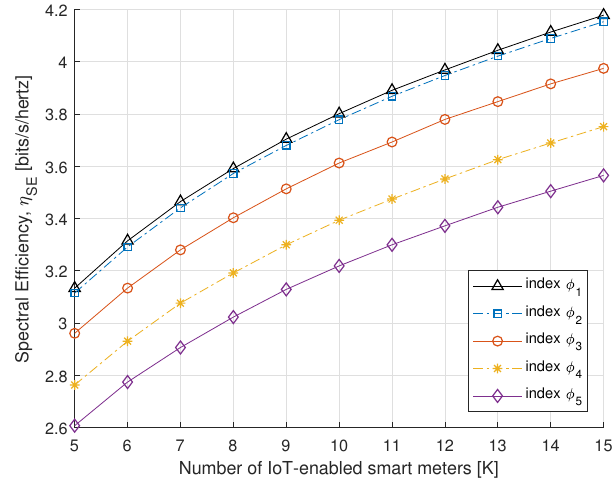
Figure 8. SE vs. number of smart meters.